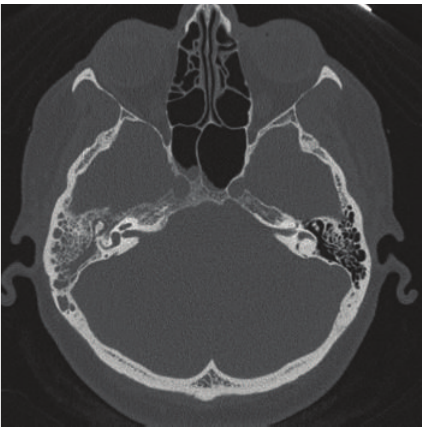
Figure 3: Axial, T1-weighted magnetic resonance imaging scans with gadolinium contrast, showing a right enhancing meningeal lesion involving the anterior and the posterior part the petrous apex with the characteristic meningeal